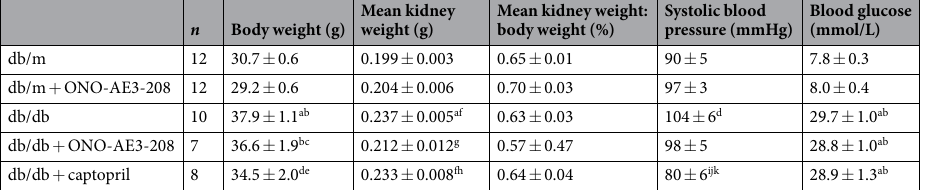
Table 2. Metabolic characteristics of db/m and db/db mice treated with vehicle (drinking water) or ONO-AE3-208 (10 mg/kg/day) or db/db mice treated with captopril (20 mg/kg/day) for eight weeks. a p < 0.0001 vs. db/m, b p < 0.0001 vs. db/m + ONO-AE3-208, c p < 0.01 vs. db/m, d p < 0.05 vs. db/m, e p < 0.01 vs. db/m + ONO-AE3-208, f p < 0.001 vs. db/m + ONO-AE3-208, g p < 0.05 vs. db/db, h p < 0.001 vs. db/m, i p < 0.05 vs. db/m + ONO-AE3-208, j p < 0.01 vs. db/db, k p < 0.05 vs. db/db + ONO-AE3-208.